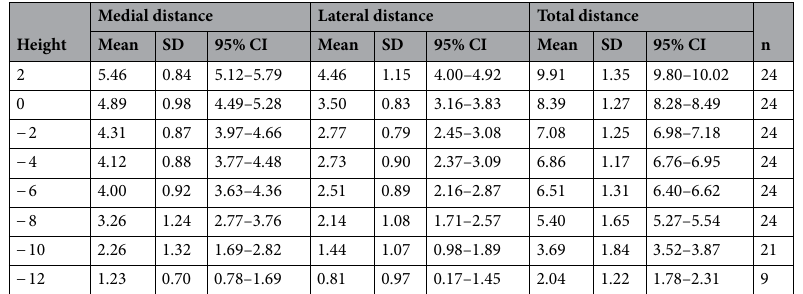
Table 2. Mean, standard deviation, and 95% confidence interval for width measurements at varying heights every 2 mm in each articular surface in the first and second TMT joints. Positive heights are dorsal to the center of the surface and negative heights are